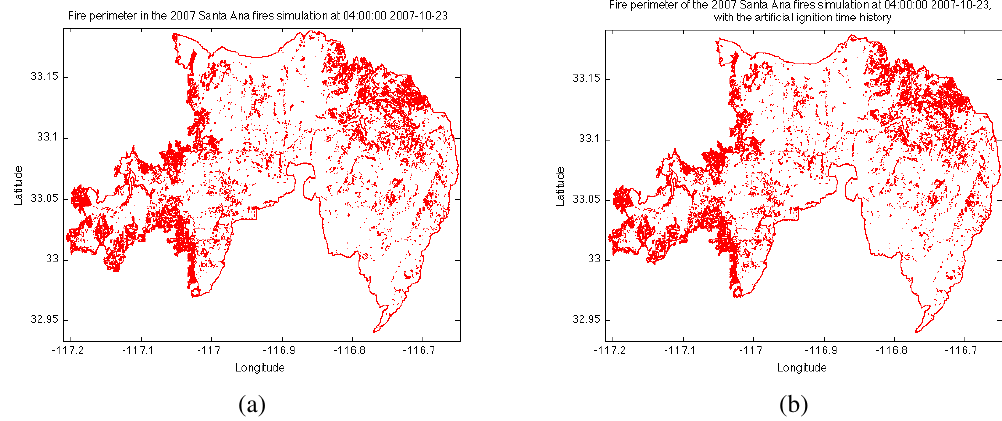
Figure 6. (a) Fire perimeter in the 2007 Santa Ana fires simulation on 22 October 22, 2007, 21:00PDT. (b) The same perimeter as in (a) , but with the artificial-ignition time history from simulation data (Fig. 4b) on 22 October 2007, 13:00PDT. The simulation with artificial fire Fig. 5. (a) Fire perimeter in the 2007 Santa Ana fires simulation at 04:00:00 2007-10-23. (b) The same history, i.e., spin-up, does not use any fire-behavior data prior to that, yet the differences in the simulation 8h later are only minor – compare, permeter as in (a), but with the artificial ignition time history from simluation data (Fig. 3b) at 20:00:00 e.g., the protuberation at the northeast part of the 2007-10-22. The simulation with artificial fire history, i.e., a spin-up, is not using any data prior to 20:00:00 2007-10-22, yet the differences in the simulation 6 hours later are only minor - compare, e.g., the protuberation at the North-East part of the perimeter.